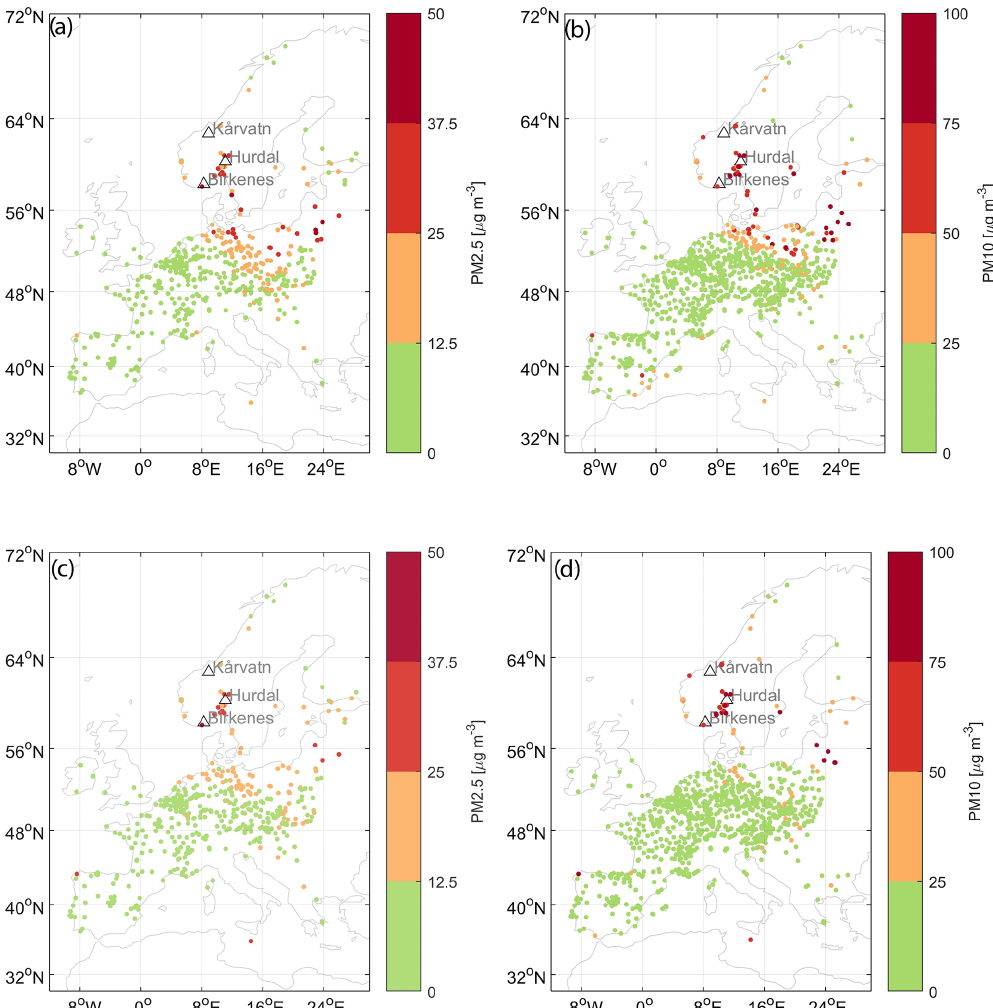
Figure 1. Mean PM 2 . 5 (a, c) and PM 10 (b, d) values (EEA, 2020) on 2 (a, b) and 3 (c, d) October 2020 (24h mean) at all EEA air quality background sites (includes urban as well as rural, but sites close to roads are excluded). Triangles indicate three Norwegian rural background sites with extensive PM speciation (Sect. 2.1.1). For comparison, the WHO air quality guidelines for maximum daily averaged PM 10 and PM 2 . 5 are 50 and 25µgm − 3 , respectively, and the EU-limit value for PM 10 is 50µgm − 3